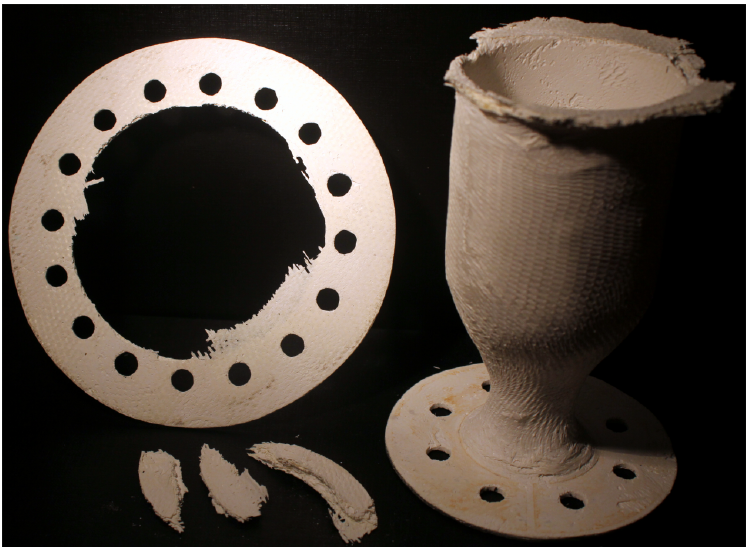
Figure 23. Prototype destroyed as a result of the pressure test with torn-off